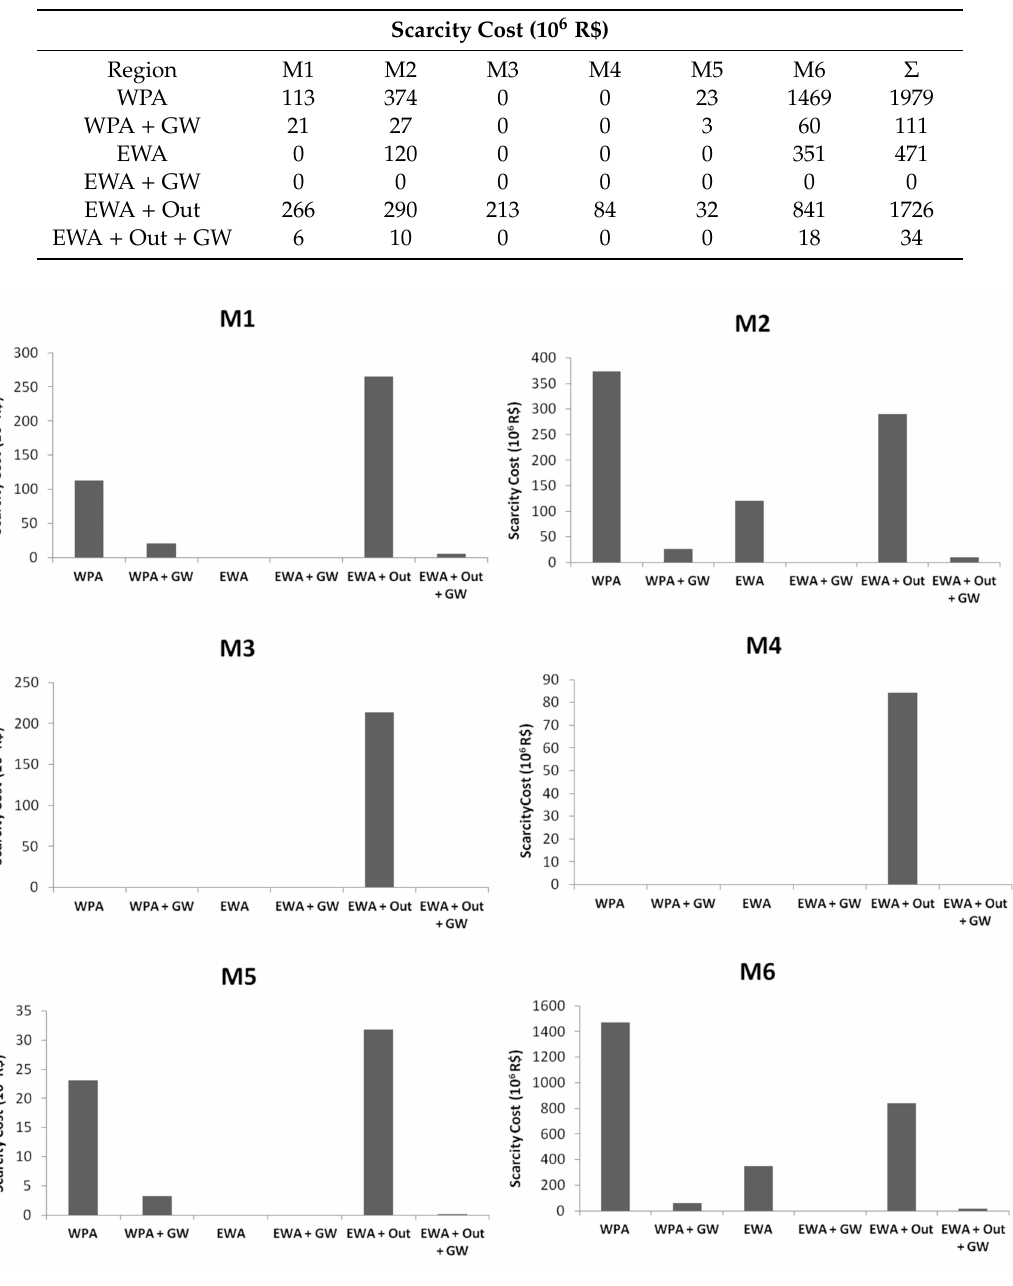
Table 4. Accumulated scarcity cost (10 6 R$) in each region for the simulated scenarios.